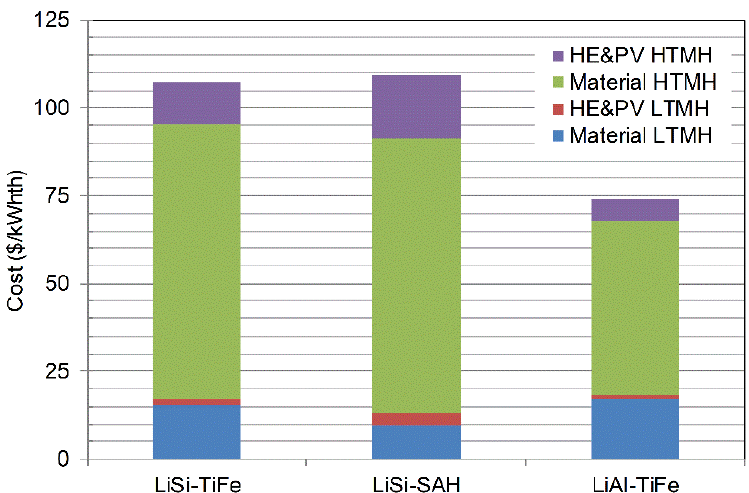
Figure 3. Specific installed costs of LiSi-TiFe, LiSi-Na 3 AlH 6 and LiAl-TiFe storage systems.